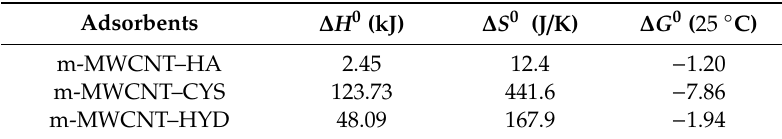
Table 4. Thermodynamic parameters for the adsorption of Ibu on m-MWCNT–HA, m-MWCNT–CYS, and m-MWCNT–HYD.